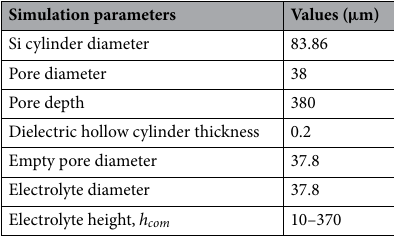
Table 2. Simulated model